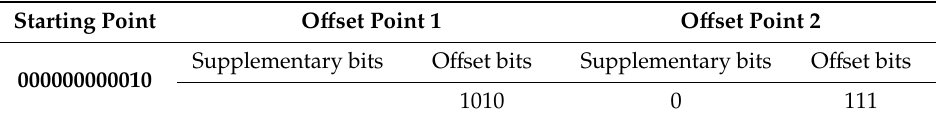
Table 2. Point feature binary offset format.